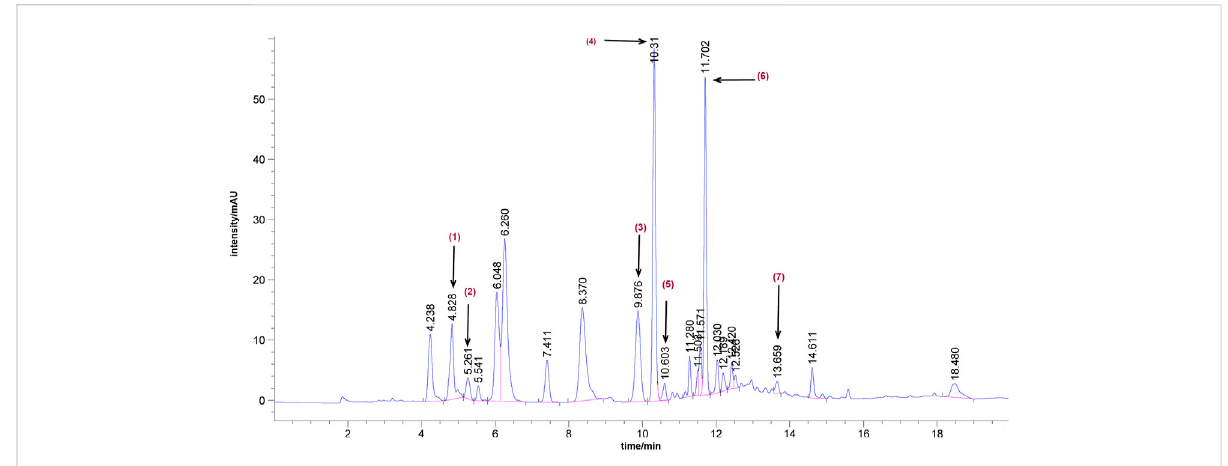
FIGURE 2 Representative UPLC chromatograms of Bailing Capsule. 1) adenine (390.85 μ g/ml), 2) uracil (73.41 μ g/ml), 3) uridine (1342.18 μ g/ml), 4) adenosine (2136.96 μ g/ml), 5) 2 ′ -deoxyadenosine (203.36 μ g/ml), 6) guanosine (20.25 μ g/ml), and 7) thymidine (1.46 μ